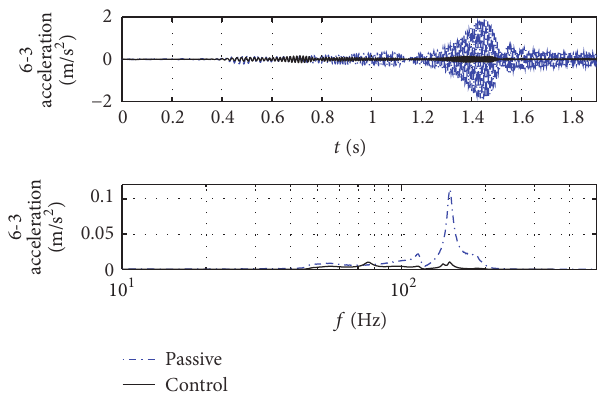
Figure 18: Comparison time-frequency domain curves of accelera- tion response of position 6-3 on the isolation system before and after being controlled under double linear swept sine interference.